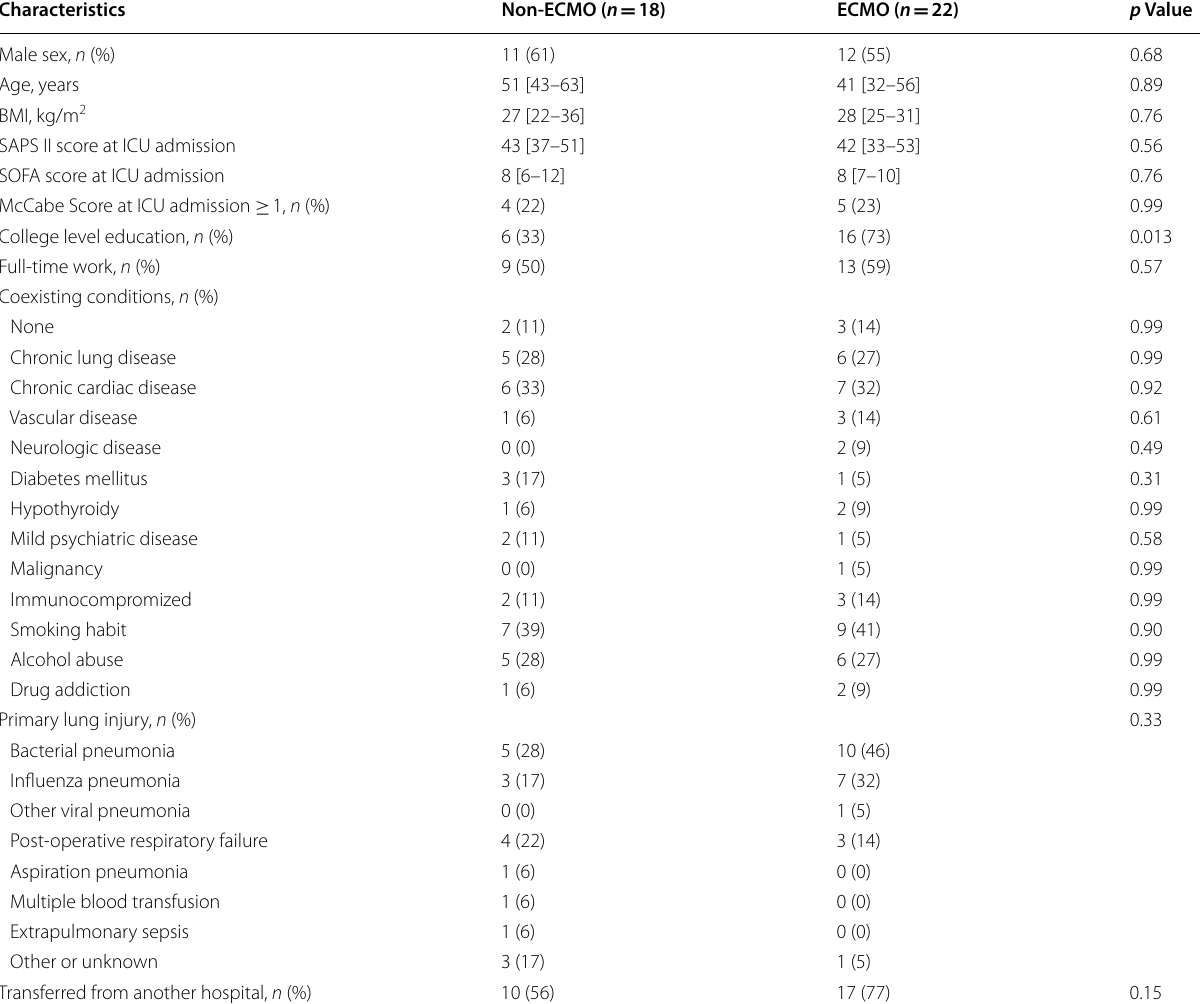
Table 1 Baseline characteristics of patients at ICU